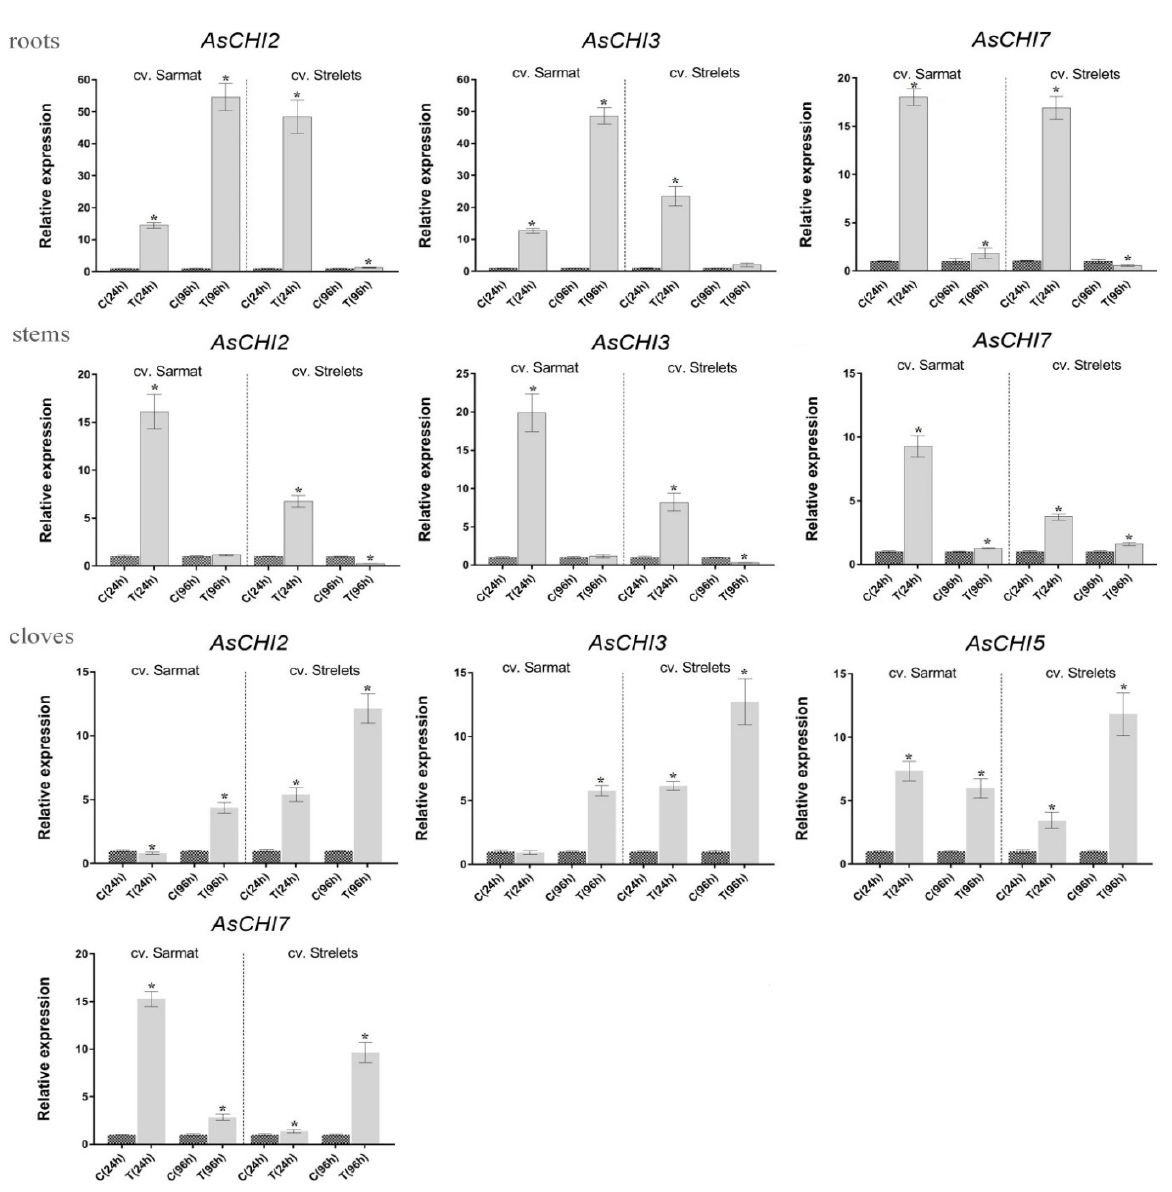
Figure 5. Expression of the AsCHI genes in roots, stems, and cloves of Allium sativum cv. Sarmat and Strelets after 24 and 96 h of Fusarium proliferatum infection. The data were normalized to GAPDH and UBQ mRNA levels and presented as the mean ± SE ( n = 3) compared to control taken as 1. * p < 0.05 compared to uninfected control.